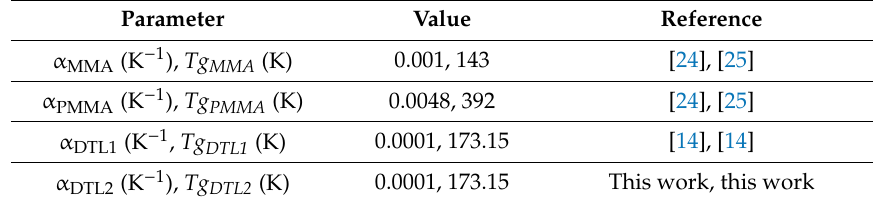
Table 3. Other free-volume